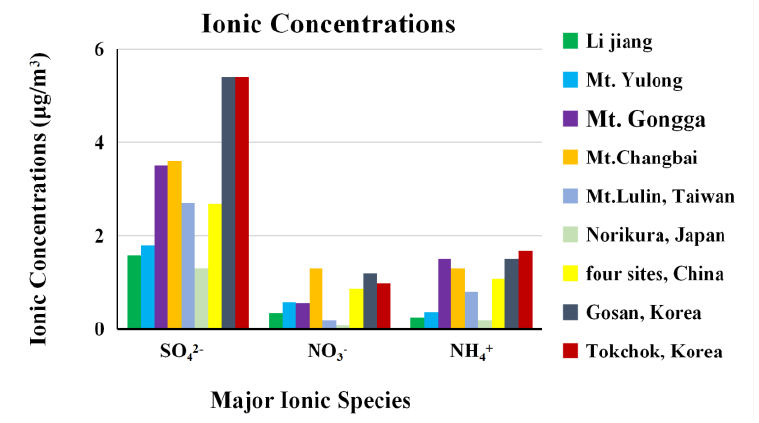
Figure 5. M ajor ionic concentrations in PM 2.5 in different rural sites.